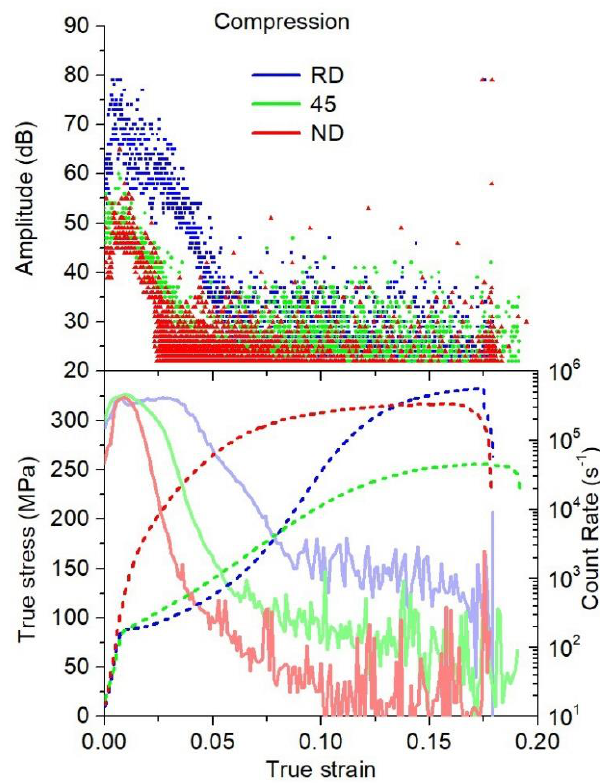
Figure 5. The deformation curves with the count rate and amplitude of AE events .